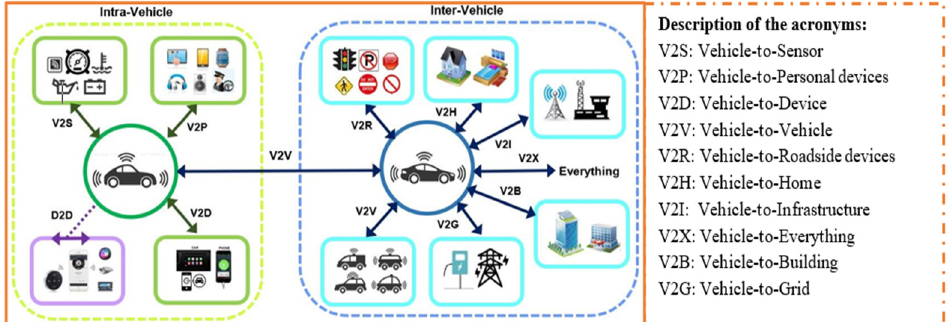
Figure 2. IoV-based network model showing V2X technologies.